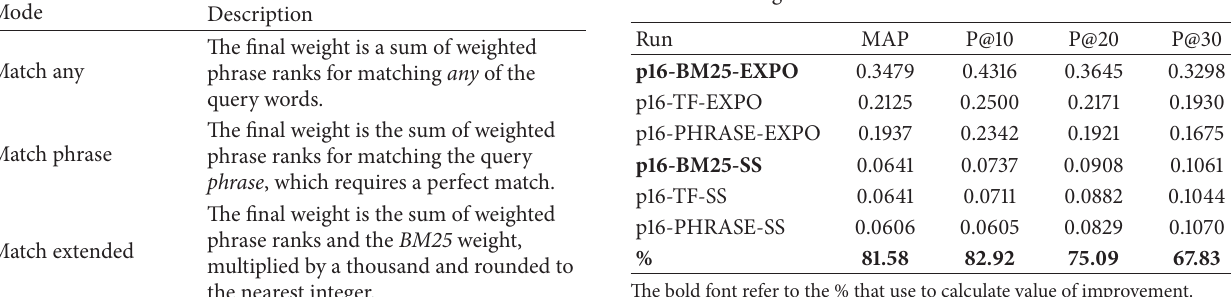
Table5:CompareperformingrunsbasedonMAPwithandwithout the score sharing.